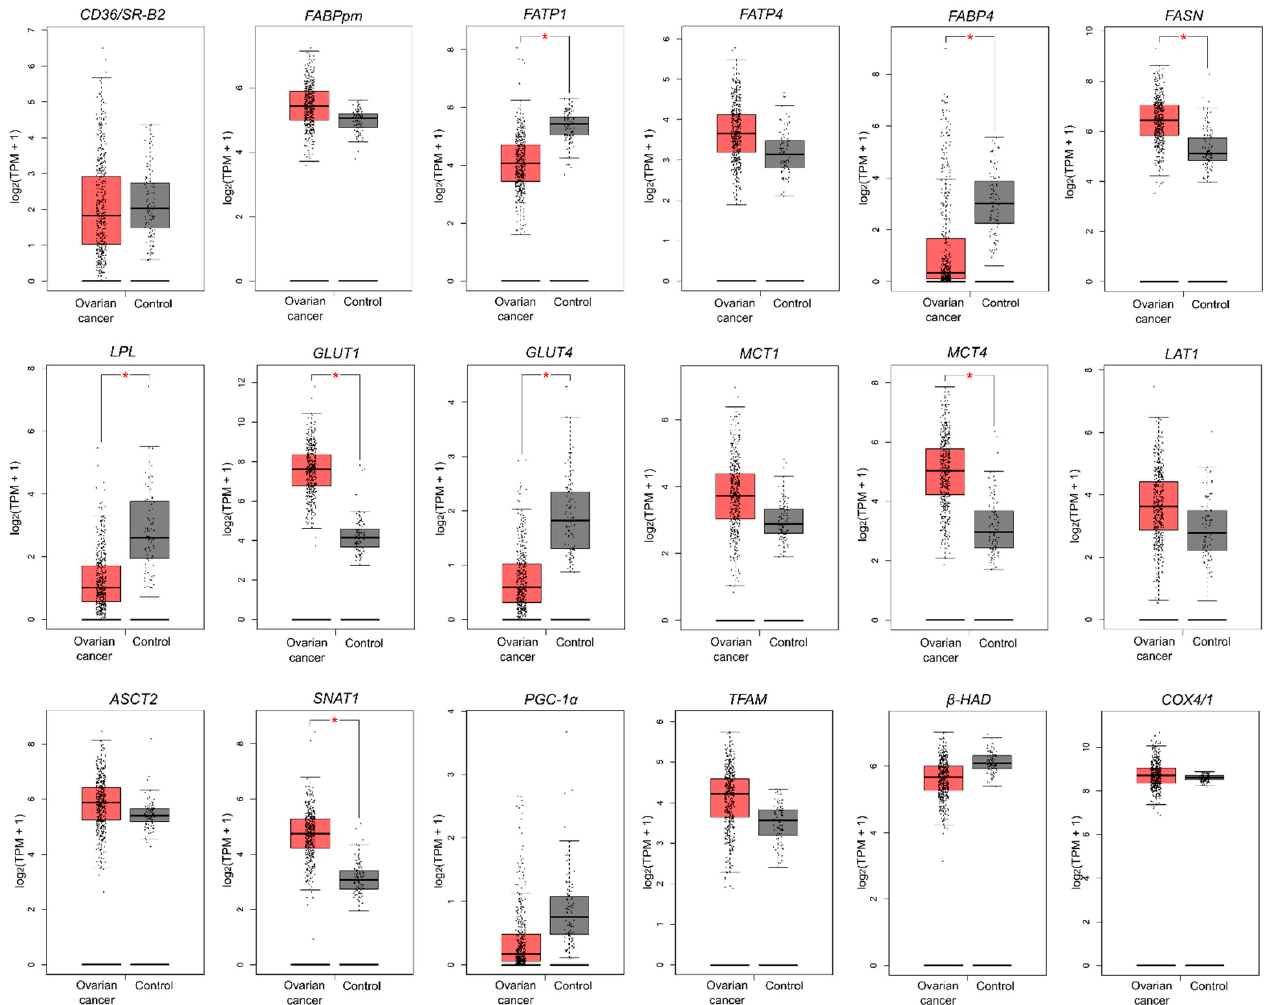
Figure 4. The transcription level of metabolism-related genes that significantly differed between ovarian cancer (n = 426) and control tissue (n = 88). Data are based on the TCGA cancer cohort and GTEx control samples. Data derive from The Gene Expression Profiling Interactive Analysis (GE- PIA) database based on the TCGA-OC dataset and normal ovarian tissues (GTEx, Genotype-Tissue Expression project). Differences statistically significant at * p < 0.05.